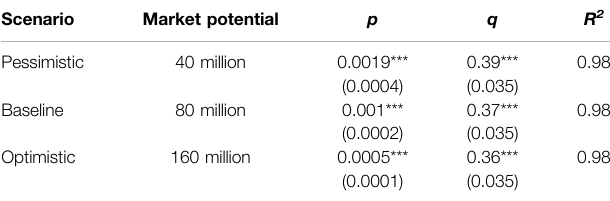
TABLE 1 | Parameters of the Bass model under different market potential